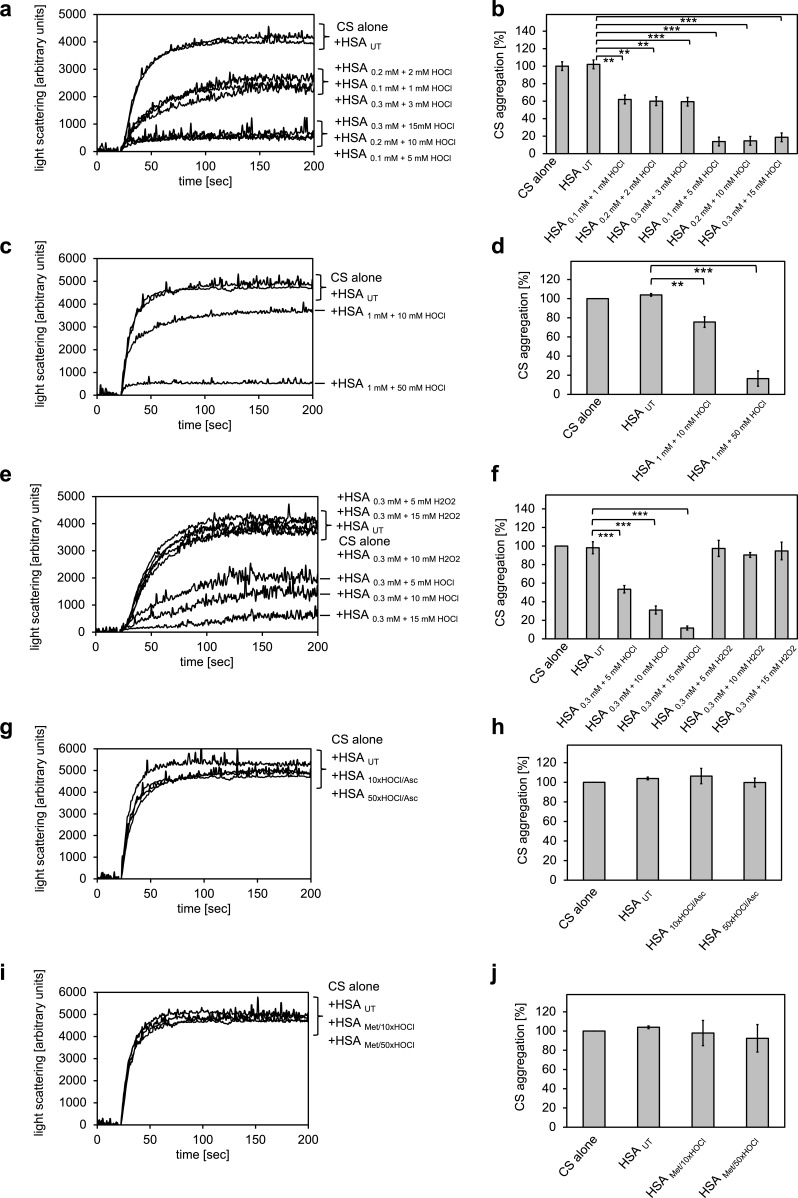
Conversion of serum albumin into a potent chaperone upon HOCl exposure is based on reversible N-chlorination of its basic amino acids.(a, b) Serum albumin in different concentrations, when treated with a 10- or 50-fold molar excess of HOCl (HSA 10xHOCl and HSA 50xHOCl, respectively), significantly decreases aggregation of chemically denatured citrate synthase as measured by light scattering at 360 nm. (c, d) After testing several concentrations, we decided to perform further experiments with 1 mM HSA treated with a 10- and 50-fold excess of HOCl. (e, f) Treatment with H2O2 does not mimic HOCl treatment. (g, h) Reduction of HOCl-treated HSA with a 50-fold molar excess of the antioxidant ascorbate (HSA 10xHOCl/Asc and HSA 50xHOCl/Asc) switches off its chaperone activity. (i, j) Methylation of basic amino acid side chains prior to HOCl treatment (HSA Met/10xHOCl and HSA Met/50xHOCl) abrogates the chaperone-like conversion of HSA. In a, c, e, g, and i representative measurements are shown. In b, d, f, h, and j data are represented as means and standard deviations from three independent experiments. Student’s t-test: *p<0.05, **p<0.01, ***p<0.001. Aggregation of citrate synthase in the absence of HSA was set to 100% and all the data are presented as percentage of this control. Labels of aggregation curves are written in the order of the final intensity of light scattering of the respective treatment.
10.7554/eLife.47395.013Figure 2—source data 1.Numerical light scattering data obtained during protein aggregation assays represented in Figure 2a and b.

10.7554/eLife.47395.014Figure 2—source data 2.Numerical light scattering data obtained during protein aggregation assays represented in Figure 2c and d.

10.7554/eLife.47395.015Figure 2—source data 3.Numerical light scattering data obtained during protein aggregation assays represented in Figure 2e and f.

10.7554/eLife.47395.016Figure 2—source data 4.Numerical light scattering data obtained during protein aggregation assays represented in Figure 2g and h.

10.7554/eLife.47395.017Figure 2—source data 5.Numerical light scattering data obtained during protein aggregation assays represented in Figure 2i and j.